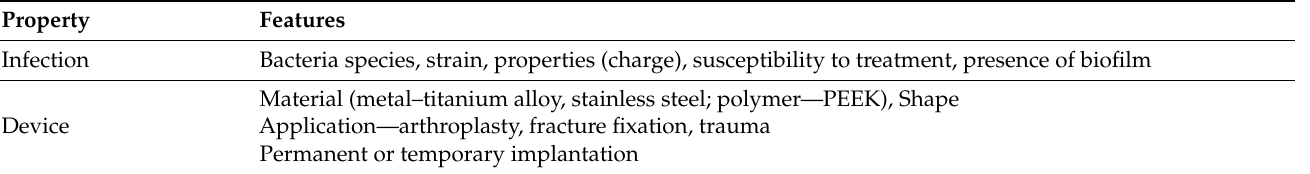
Table 1. Considerations in the design of orthopaedic devices to mitigate device-related